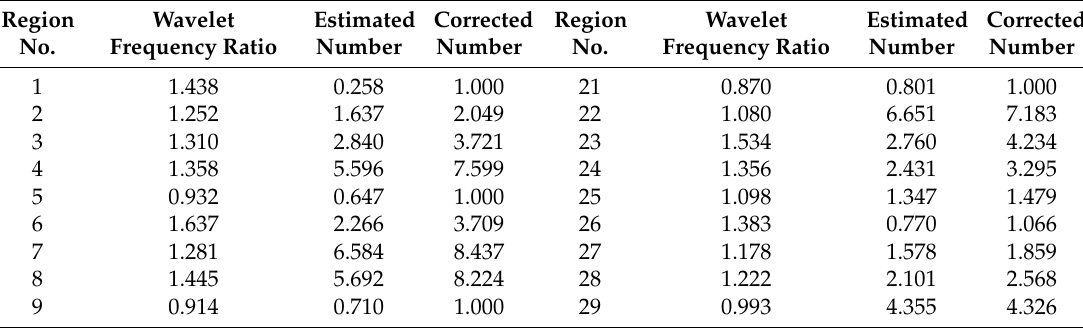
Table 2. Results for sample B *.